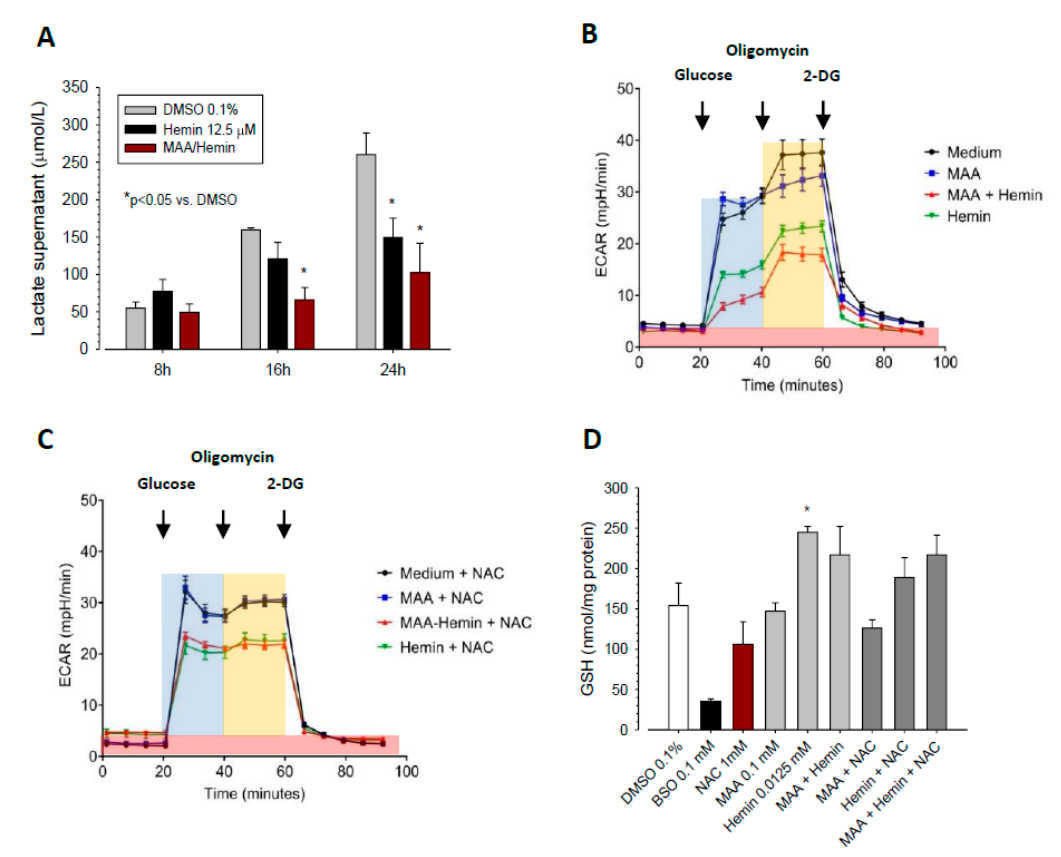
Figure 4. Effect of MAA and/or hemin on lactate production, extracellular acidification (ECAR) and the glutathione (GSH) content of HL60 cells. HL60 cells were cultured in 10 mM glucose and treated with the toxicants for 24 h. ( A ) Cellular production of lactate. The quantification is given in Table 1. ( B ) ECAR in the supernatant of HL60 cell treated with the toxicants as a marker of glycolysis. Glucose (10 mM), oligomycin (1 µM), and 2-deoxyglucose (2-DG) (62.5 mM) were added as indicated in the figure. Highlighted in light blue: glycolysis; highlighted in orange: maximal glycolytic capacity, highlighted in red: non-glycolytic acidification. ( C ) Acidification rate in the presence of the different toxicants and 1 mM N-acetylcysteine (NAC). ( D ) GSH content in HL60 cells after exposure to the toxicants for 24 h. n = 3 observations in triplicate presented as the mean ± SEM. * p < 0.05 vs. vehicle-treated control incubations (medium containing 0.1% DMSO); MAA 100 µM, hemin 12.5 µM.